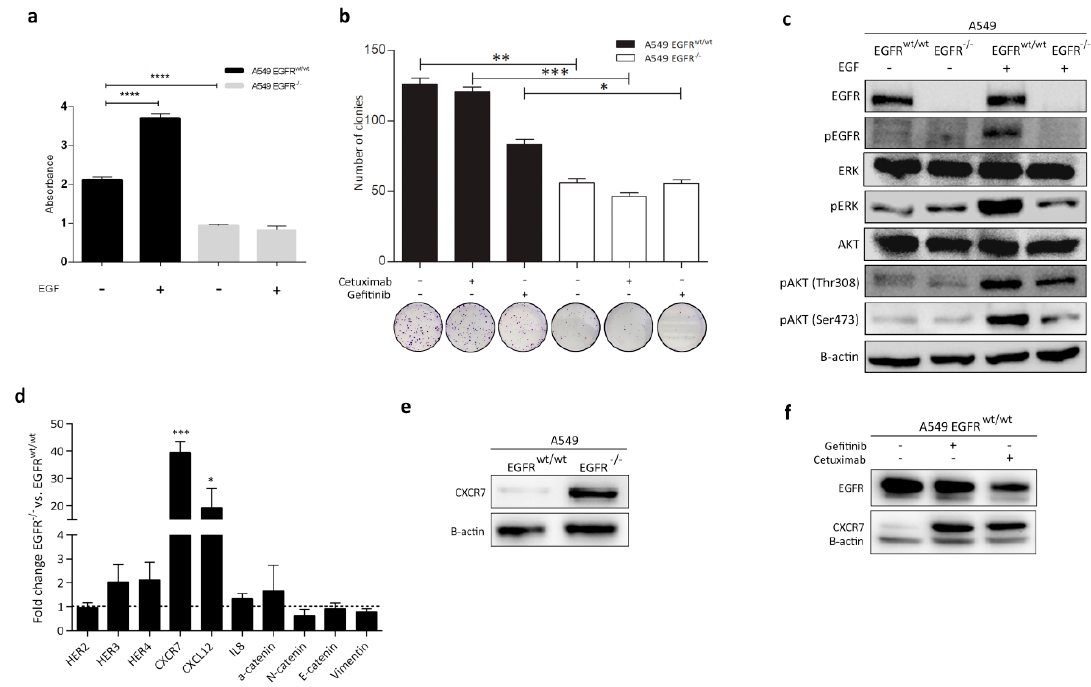
Figure 3. Effect of different treatments on cell proliferation and expression of EGFR downstream signaling proteins in A549 EGFR wt/wt and EGFR − / − cells. ( a ) Proliferation analysis of EGFR wt/wt and EGFR − / − cells in the presence and absence of EGF. Cells were cultured in serum-starved medium (2% serum). ( b ) Colony formation ability of EGFR wt/wt and EGFR − / − cells before and after treatment. ( c ) Western blot analysis of EGFR downstream proteins before and after stimulation with EGF for 15 min. ( d ) Relative mRNA expression of the selected genes. ( e ) Western blot analysis of CXCR7 in EGFR wt/wt and EGFR − / − cells. ( f ) CXCR7 protein expression in EGFR wt/wt cells treated with 0.5 µ M gefitinib and 100 nM cetuximab for 72 h. Data in bar graphs are represented as mean ± SD ( n ≥ 3); two-tailed unpaired student’s t -test: * p -values < 0.05; ** p -values < 0.01; *** p -values < 0.001.